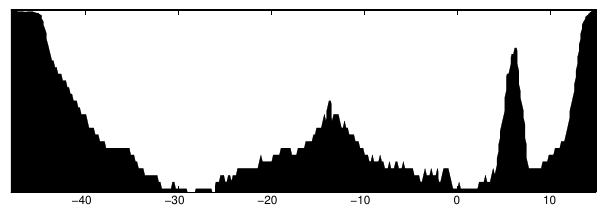
Fig. 1. Bottom topography of section at 24 ◦ Figure 1. Bottom topography of section at 24 o S. 3